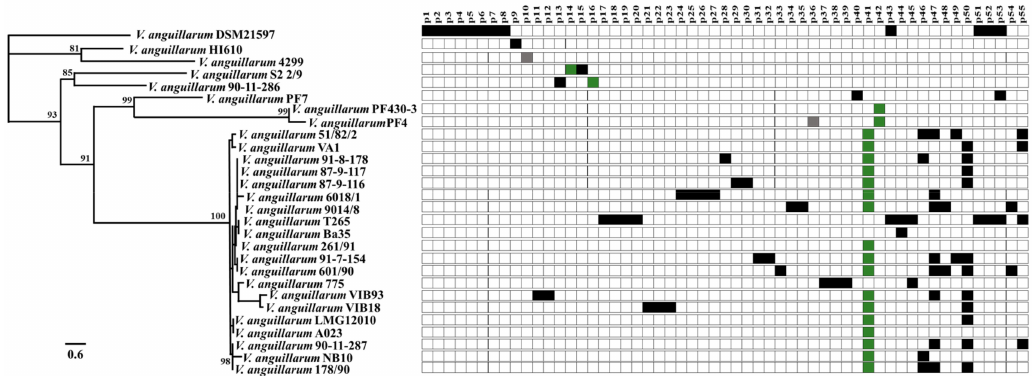
Figure 1. In silico detection and distribution of prophage-like sequences in V. anguillarum strains. Unrooted core phylogenetic tree of the 28 V. anguillarum strains based on 1723 concatenated genes (both chromosomes) [13]. Bootstrap values of < 80% were removed from the tree. The horizontal bar at the base of the figure represents 0.6 substitution per amino acid site. Presence of specific prophage-elements are labeled by colored squares. Green, gray and black squares indicate complete, questionable and incomplete prophage-like elements